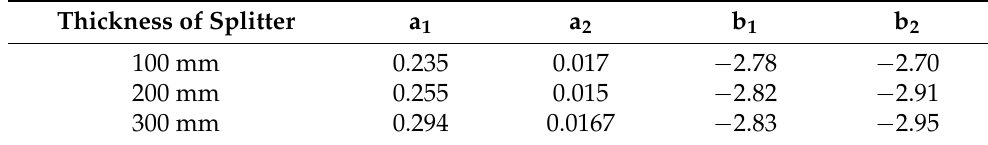
Table 1. Values of the coefficients for the calculation of the pressure loss coefficient (Equation (5)) in VDI